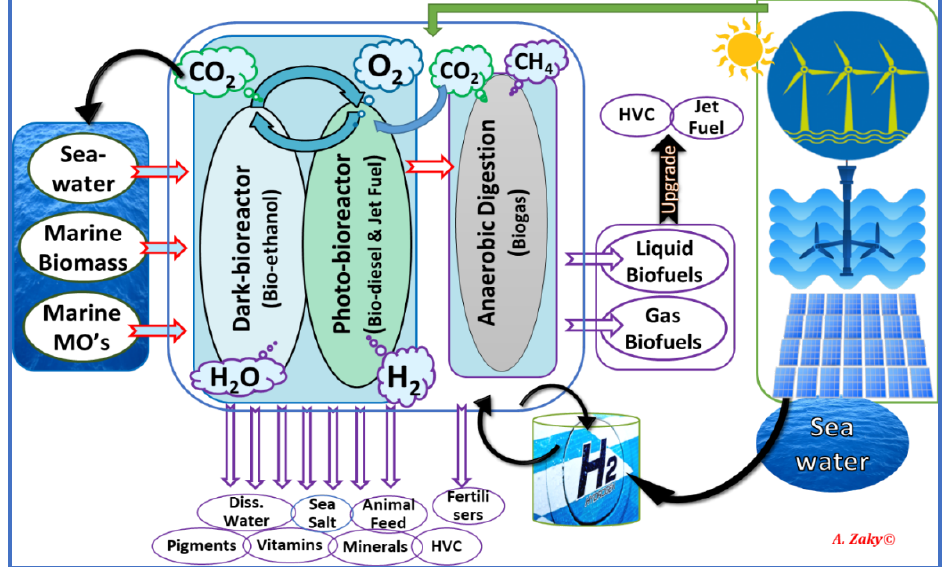
Figure 8. Coastal integrated marine biorefinery and renewables (CIMBR)